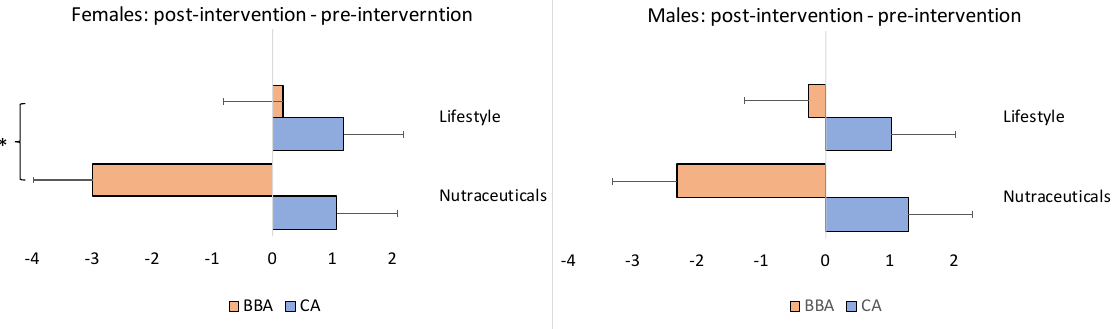
Figure 4. Difference between the post- and pre-intervention endpoints as a function of the intervention (i.e., nutraceutical supplementation versus lifestyle changes) separately for the female and male subgroups. The x - axis represents the difference in years. CA: chronological age; BBA: biological brain age. The asterisk denotes p < 0.05 (*). The bars represent the means with standard errors. The negative values indicate brain age reversal, a “zero” value indicates brain age stabilization (i.e., slowdown), and positive values indicate brain aging.